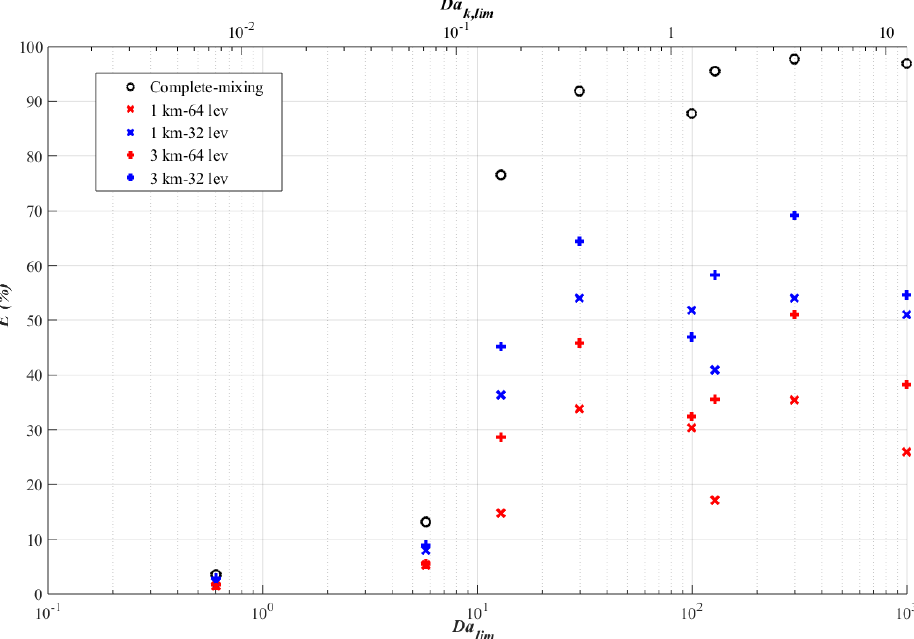
Figure 8. Plot of the model errors E in percentage from the complete-mixing model (black circles) and the four coarse-grid models ( + and × in red and blue) against the corresponding Damköhler number of the limiting reactant ( Da lim ) (and the corresponding Kolmogorov Damköhler number of the limiting reactant ( Da k,lim ) (upper x axis)) for the simulations with homogeneous emissions.